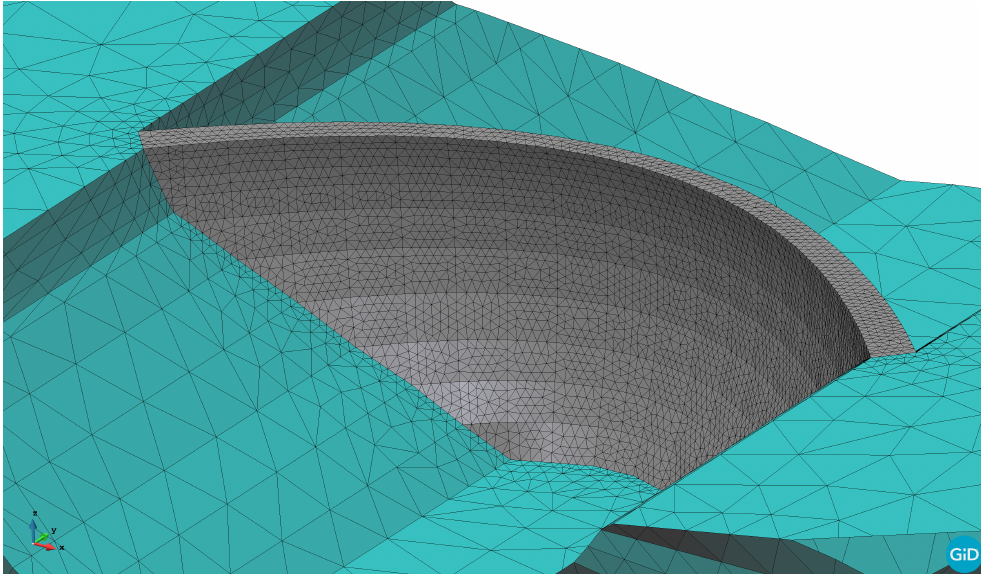
Figure 2. Close view of the dam body and the mesh elements.